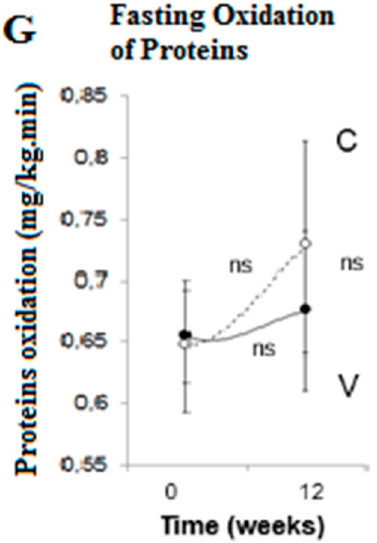
Figure 1. Changes in physical fitness in response to a vegetarian (V, full line and full circles) and conventional diet (C, dashed line and empty circles). Data are means ± 95% confidence intervals. Significant changes from baseline to 12 weeks within groups assessed by paired comparison t -tests are indicated by * for p < 0.05, ** for p < 0.01, and *** for p < 0.001. p -values for the interaction between factors group (vegetarian and control group) and time (0 and 12 weeks) assessed by repeated measures. ANOVA are: p = 0.048 for maximal performance ( A ), p = 0.004 for maximal oxygen consumption, VO 2max ( B ), p = 0.067 for resting energy expenditure ( C ), p = 0.666 for respiratory quotient ( D ), p =